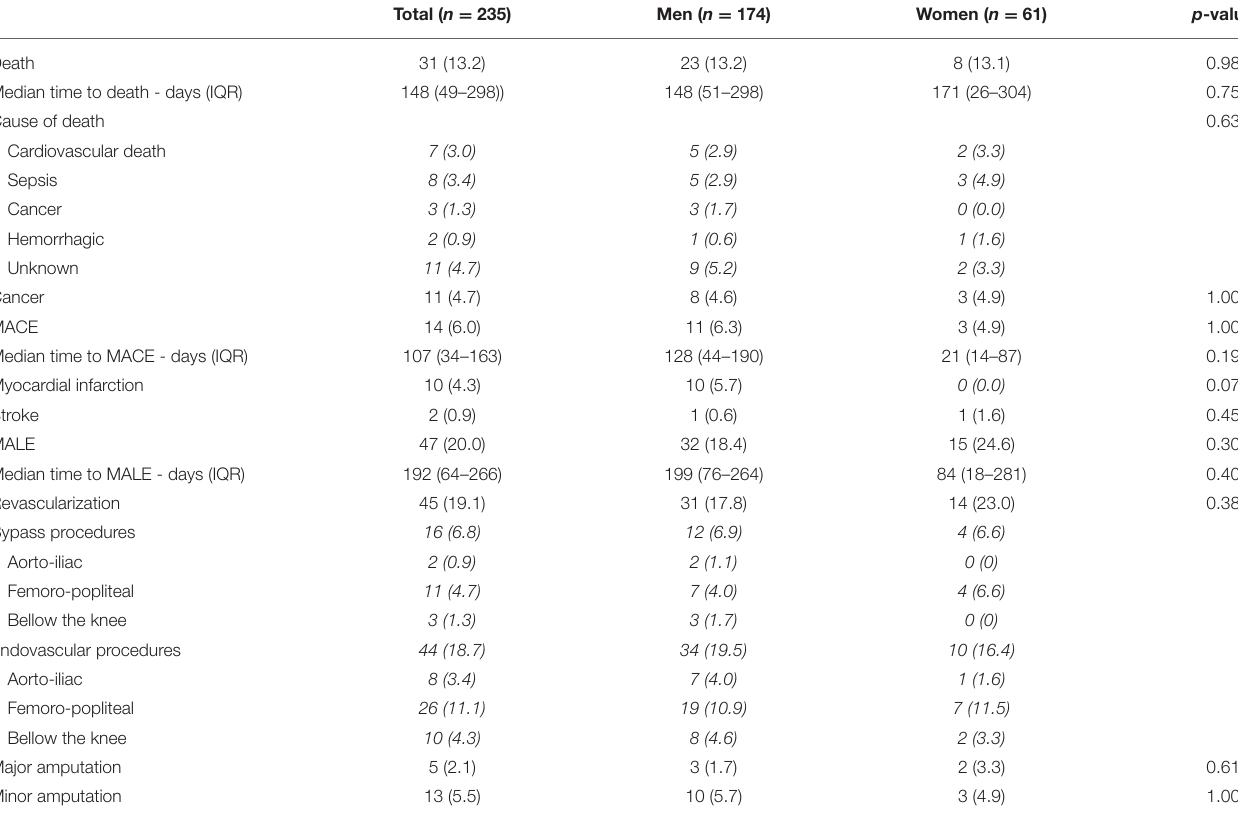
TABLE 2 | One-year